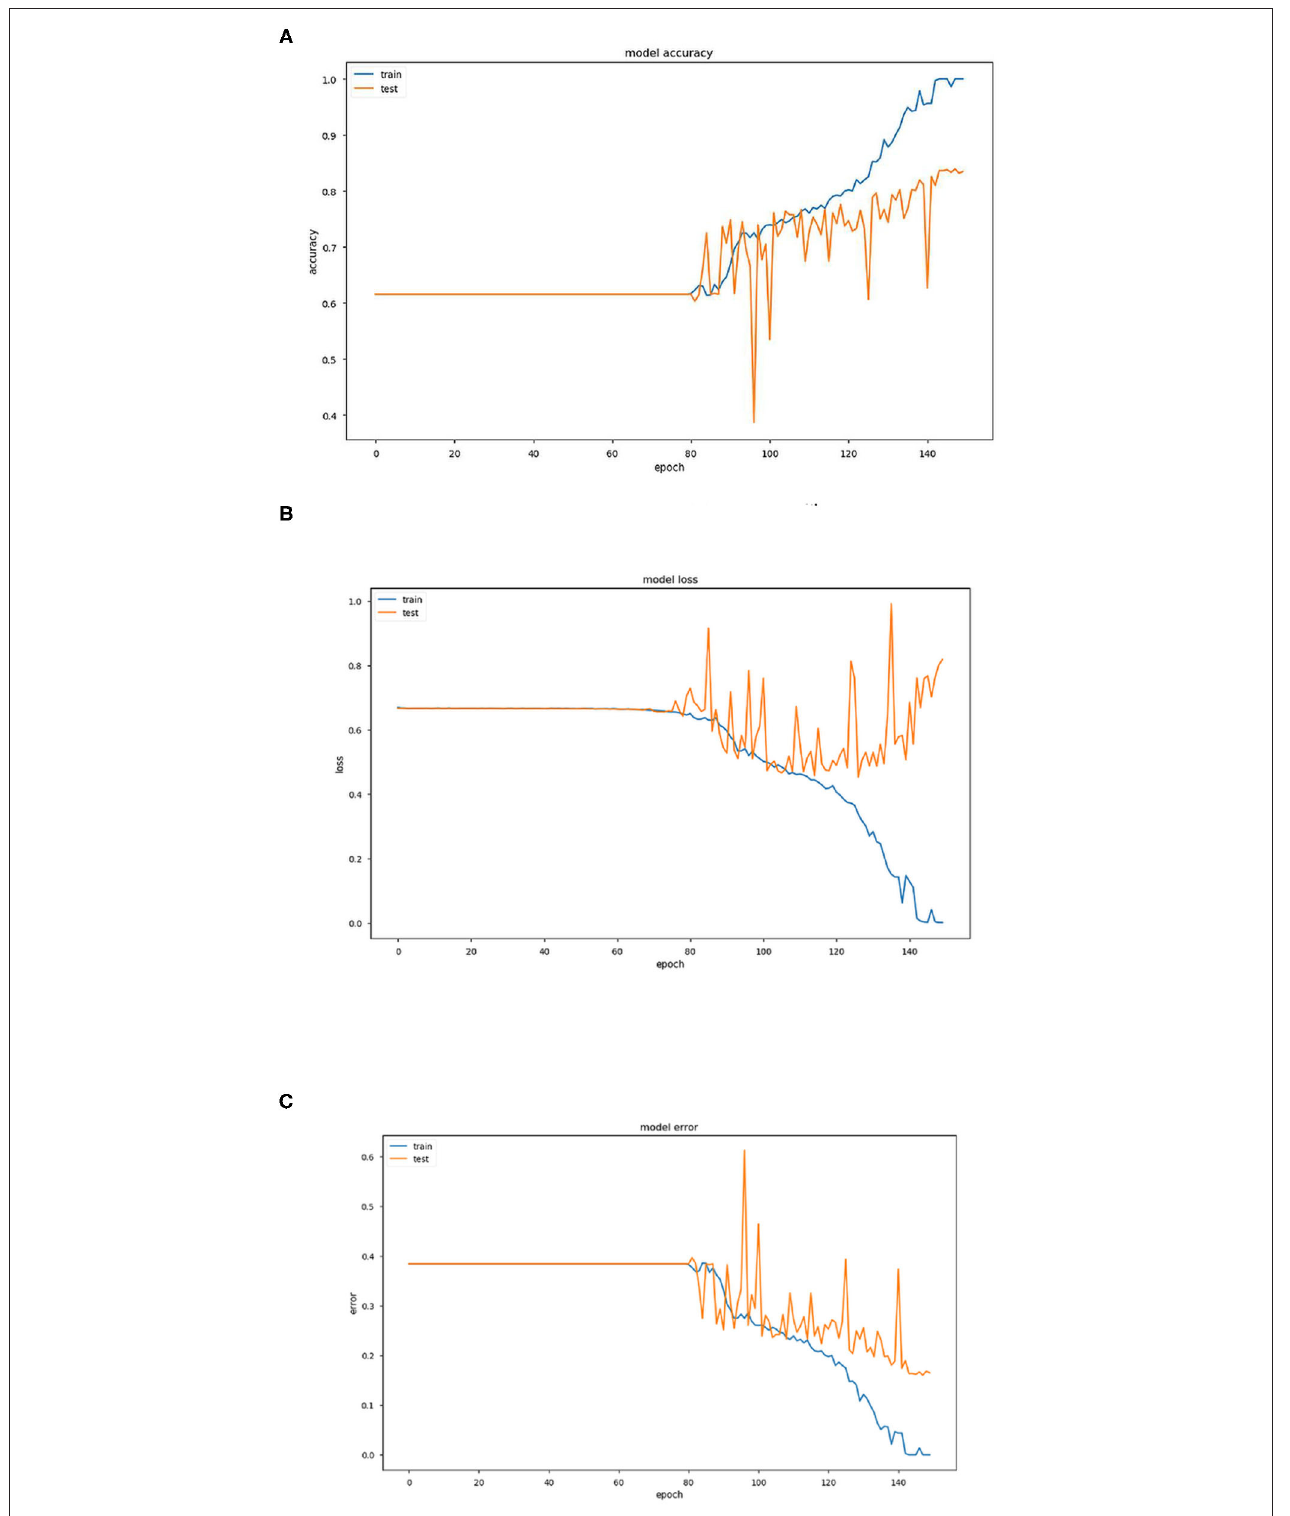
FIGURE 2 | (A) Graph representing variation of model accuracy with respect to epoch. (B) Graph representing variation of model loss with respect to epoch. (C) Graph representing variation of model error with respect to epoch.